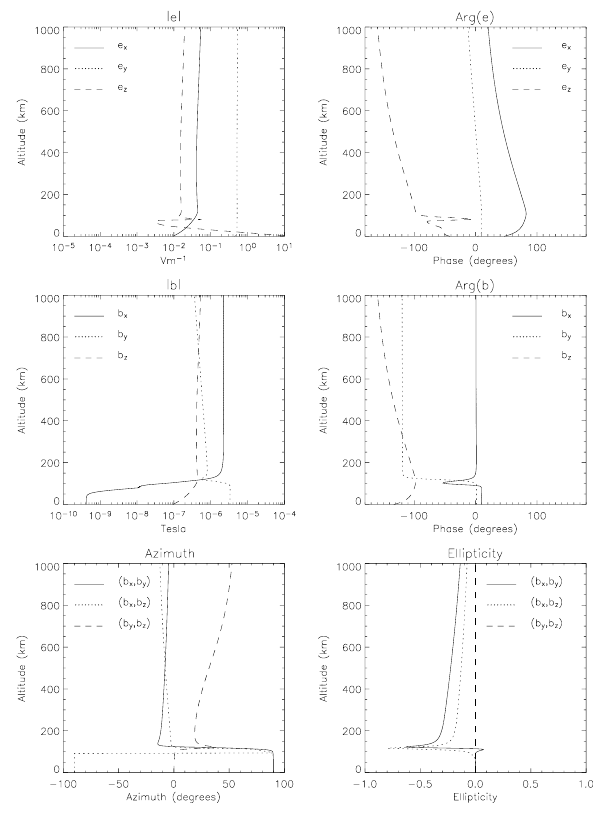
Fig. 2. ULF wave fields and polarisation azimuth for k x =10 − 10 m − 1 , k y = 10 − 6 m − 1 and ω =0.1 ( f ≈ 16mHz). The dip angle is 70 ◦ . Compare with Fig. 4. in Hughes